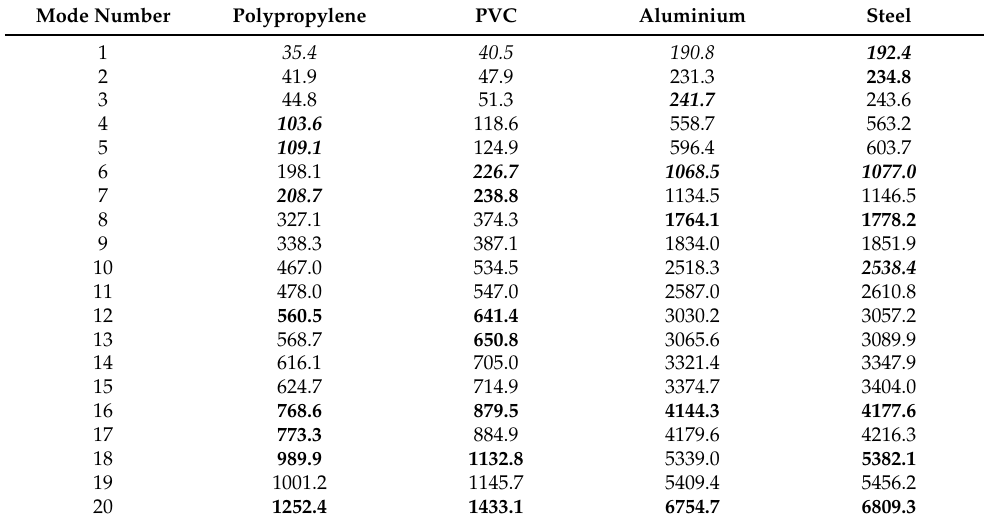
Table 10. Computed natural frequencies for each material (in Hz) ( italics —frequencies that coincide with cavity wall vibration spectrum frequency peaks (Section 4.2), bold —frequencies that coincide with noise spectrum frequency peaks (Section 4.3)).